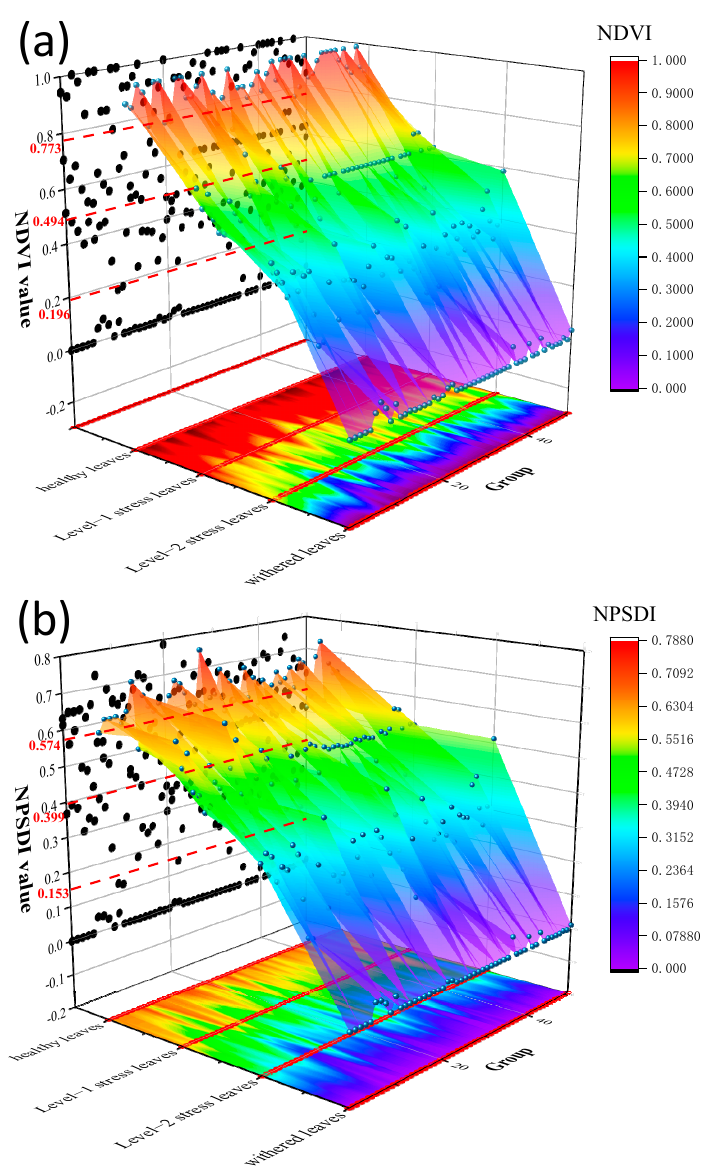
cut-off line between a withered leaf and level-2 stressed leaf laid at 0.153 and that be- tween a level-1 stressed leaf and level-2 stressed leaf and that between a healthy leaf and level-1 stressed leaf laid at 0.399 and 0.574, respectively. Table 1 also contains the sensi- tivity and specificity for classifying different levels of the plant health status according to the scatter plot shown in Figure 13b, as well as the corresponding PPV and NPV.